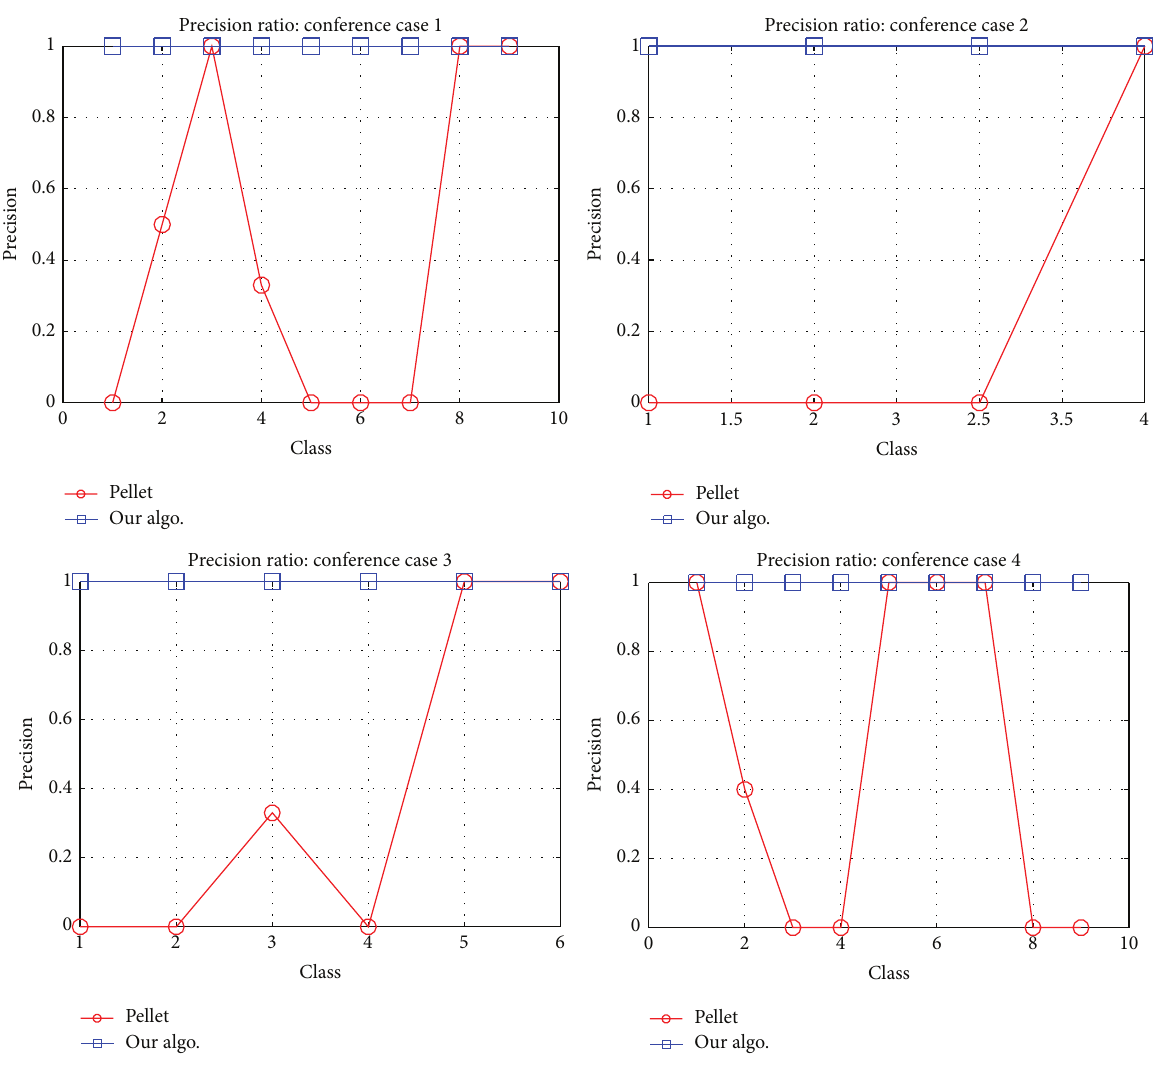
Figure 6: Subclasses calculation precision ratio by Pellet and our algo.: conference cases 1, 2, 3, and 4. Table 11: UnionIntersectionMatch algorithm’s improved